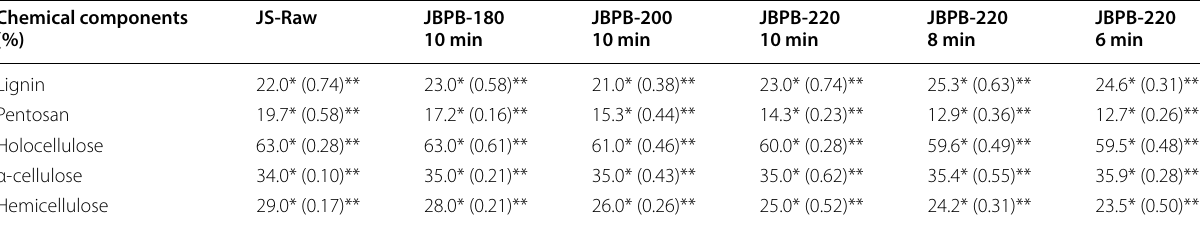
Table 3 Chemical compositions of Jute stick and Jute Stick Binderless Particleboard (JBPB) pressed at different press temperatures and times